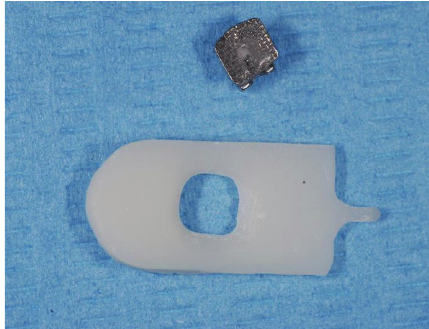
Figure 1: Ceramic mask equipped with the central hole of the size corresponding to the bracket base.